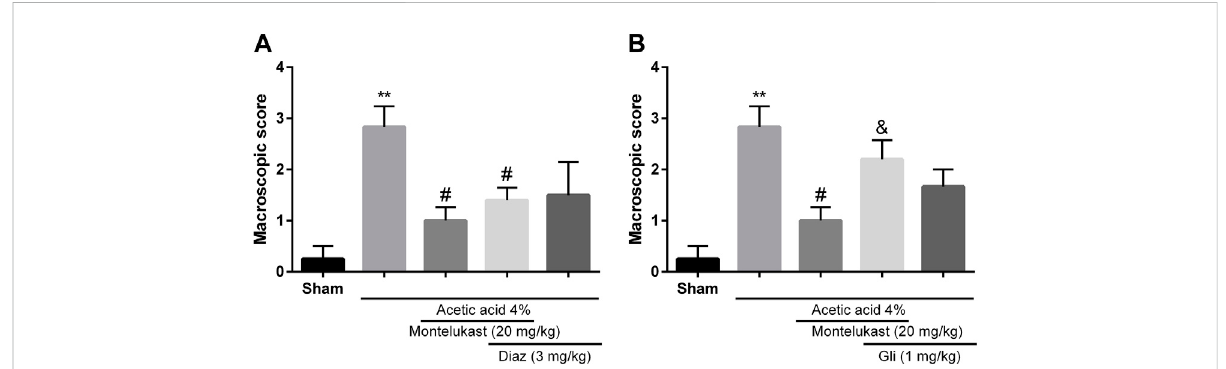
FIGURE 4 Evaluation of theinvolvement ofthe KATP channel inthe protective effect of montelukast (Mon, 20 mg/kg) on the macroscopicscore ofcolon tissue. The effect of pre-treatment with diazoxide (Diaz, 3 mg/kg, (I) p.) and glibenclamide (Gli, 20 mg/kg, (I) p.) on the effect of Mon is shown in panels (A) and (B) , respectively. The results are expressed as the means ± SEM of six rats per group. ** p < 0.01, when compared to the Sham group; # p < 0.05whencomparedtotheaceticacidgroup; & p < 0.05,whencomparedtotheMon-treatedgroup.Thestatisticalanalysiswasperformed by ANOVA followed by Tukey ’ s post hoc test.